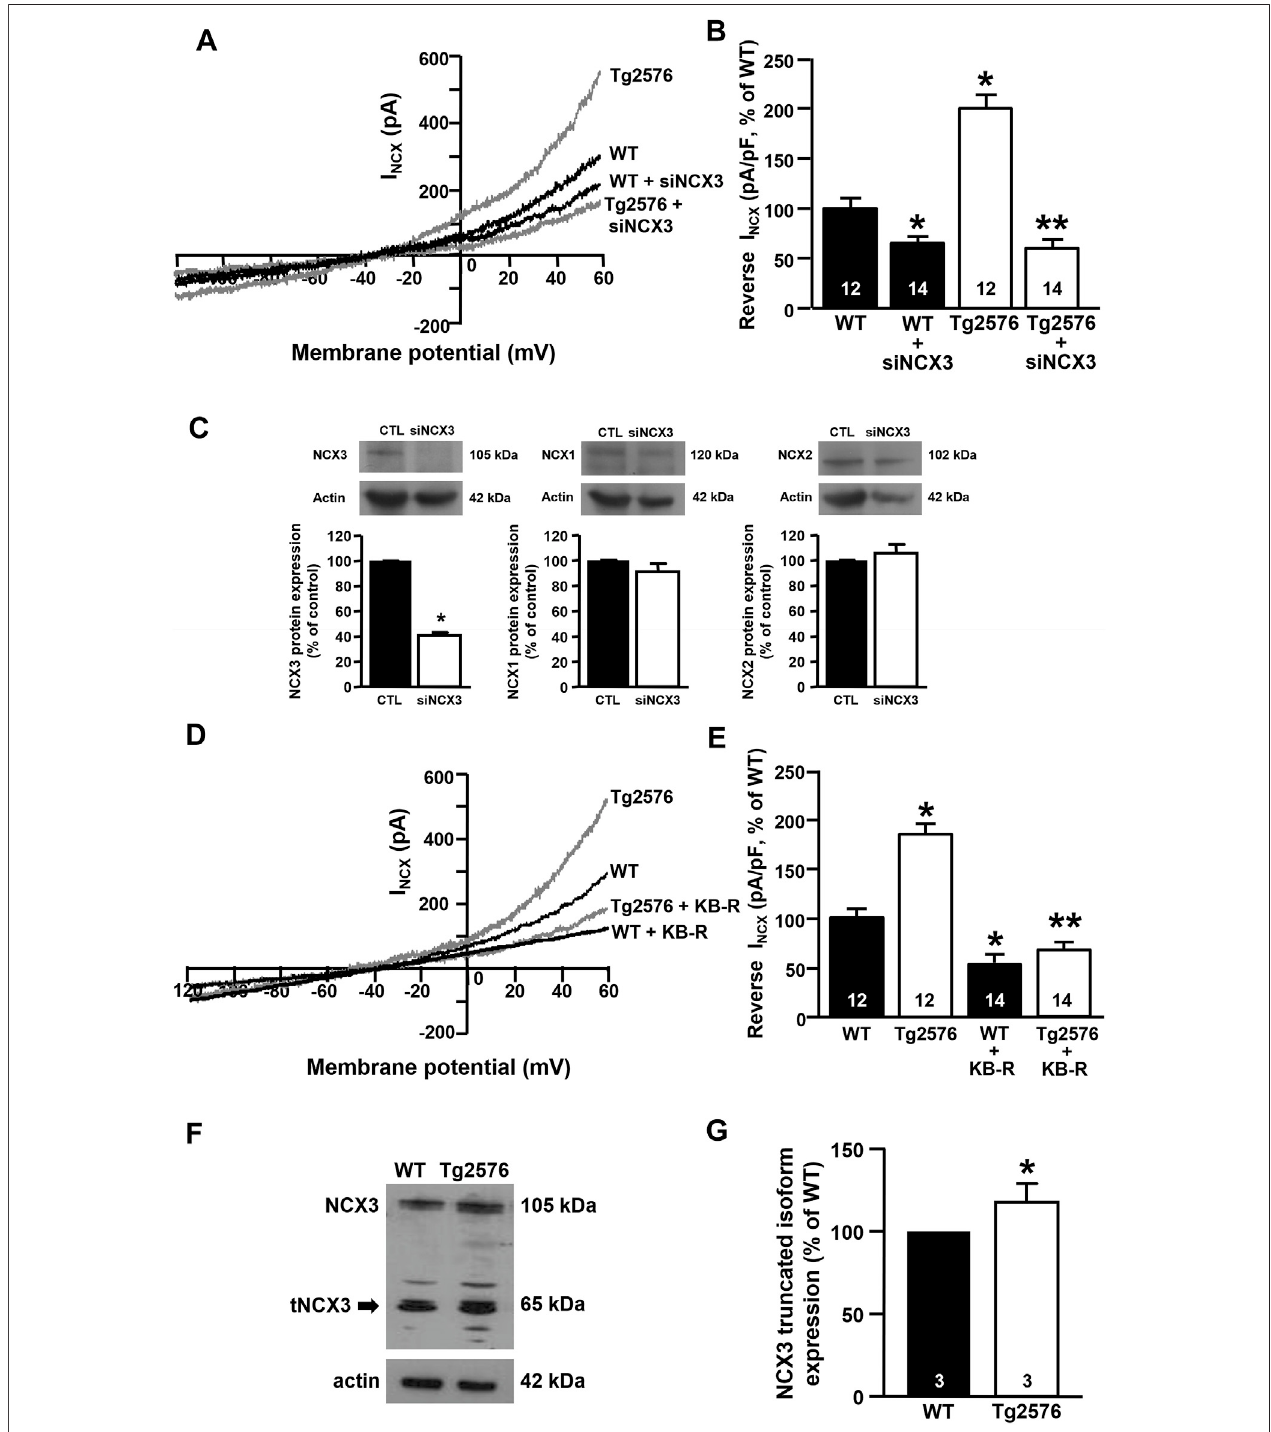
FIGURE 2 | Effect of NCX3 silencing or inhibition by KB-R7943 in WT and Tg2576 primary hippocampal neurons. (A) Representative superimposed traces of I NCX in the reverse and forward modes of operation recorded in WT and WT plus siNCX3 (black traces), Tg2576 and Tg2576 plus siNCX3 (grey traces) primary hippocampal neurons at 12 DIV. (B) Quanti fi cation of I NCX in the reverse mode of operation represented in A, expressed as percentage of variation in comparison to WT. Values are expressed as mean ± SEM of 3 independent experimental sessions. (C) Representative Western blotting experiments and relative quanti fi cations showing the effectofNCX3silencing(siNCX3)onNCX3,NCX1,andNCX2proteinexpressioninprimaryhippocampalneurons (D) RepresentativesuperimposedtracesofI NCX inthe reverse and forward modes of operation recorded from WT and WT plus 0.5 μ M kB-R7943 (black traces), Tg2576 and Tg2576 plus 0.5 μ M kB-R7943 (grey